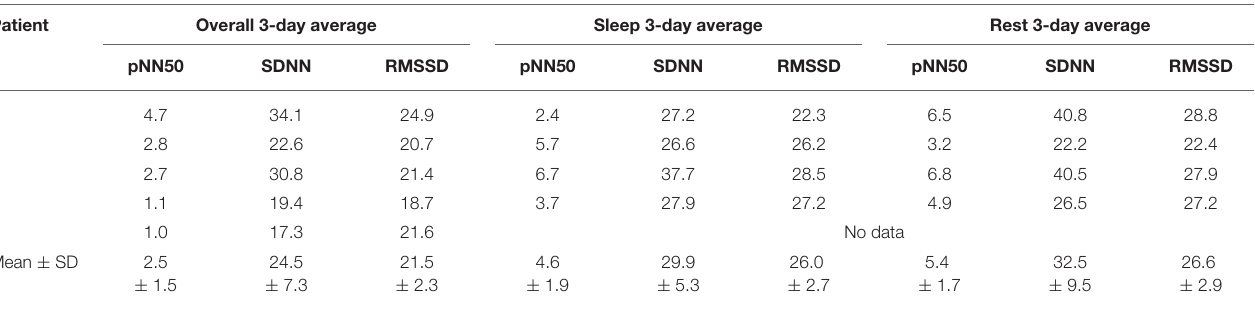
TABLE 1 | Time-domain results (3-day average: overall, sleep, rest) in ALS patients.